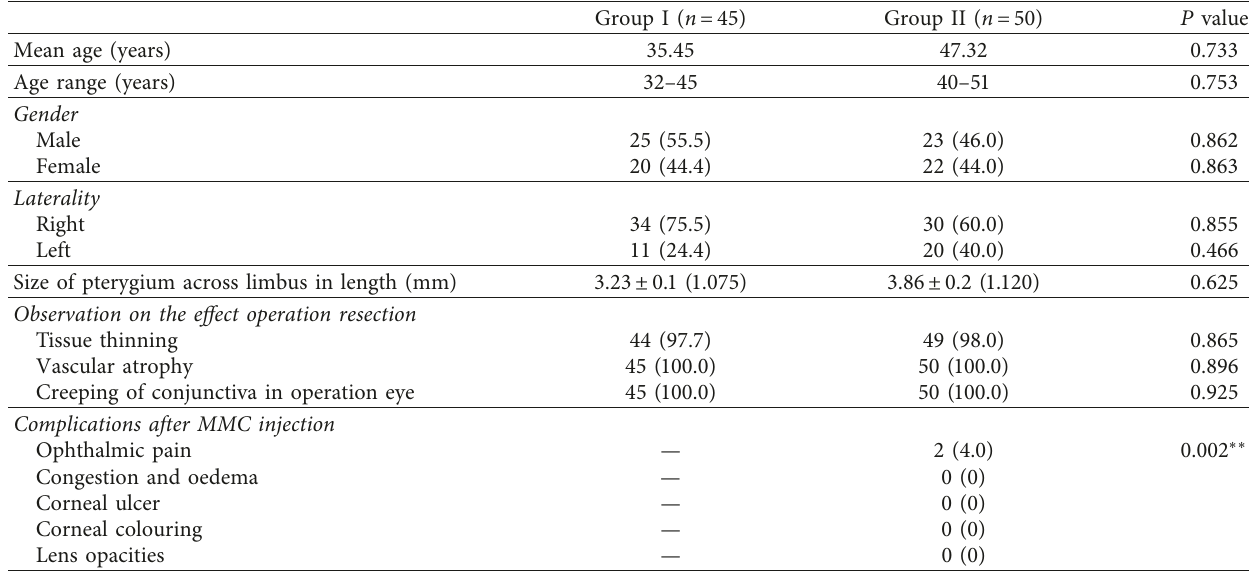
Table 1: Demographic and clinical data of pterygium patients in group I (no MMC injection) and group II (MMC injection).